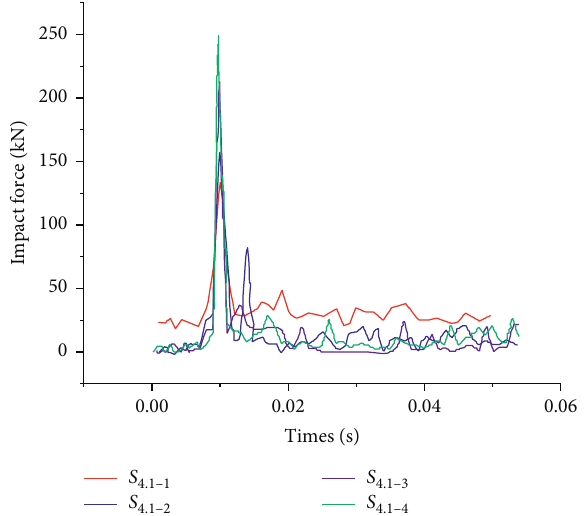
Figure 17: Time chart of impact forces at different falling heights of the pendulum ball.